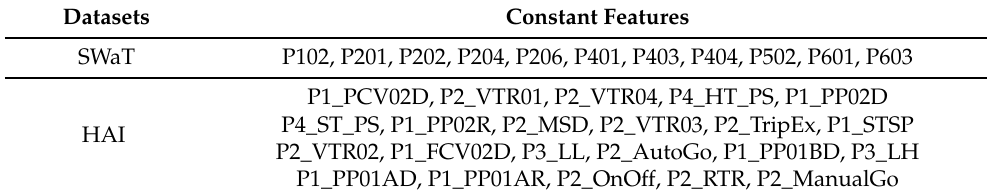
Table 3. Constant features in the SWaT and HAI